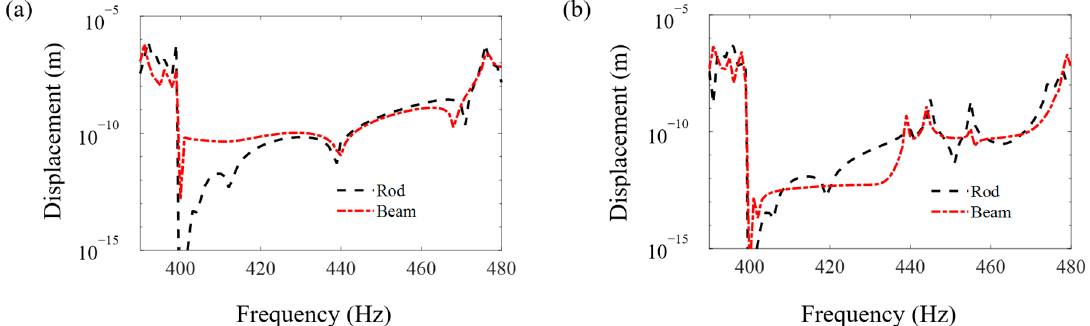
Figure 8. The FRF curves of the metamaterial plates with the beam cores and rod cores near the first axial vibration band-gaps in the z direction of the beams at points A and B of the cover plates. ( a ) Point A and ( b ) point B .